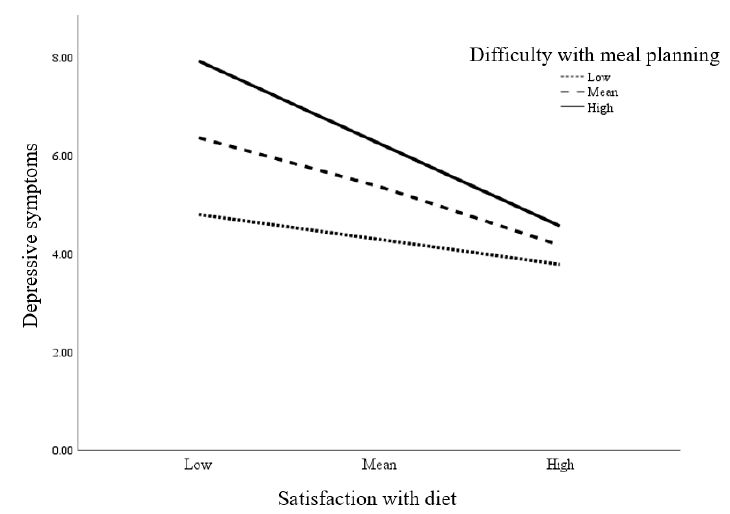
Figure 1. Moderating effect of difficulty with meal planning on the relationship between satisfaction with diet and depressive symptoms in older adults with diabetes. Low, mean, and high levels of satisfaction with diet and difficulty with meal planning were determined at − 1SD from the mean (Low), mean, and +1SD from the mean (High).